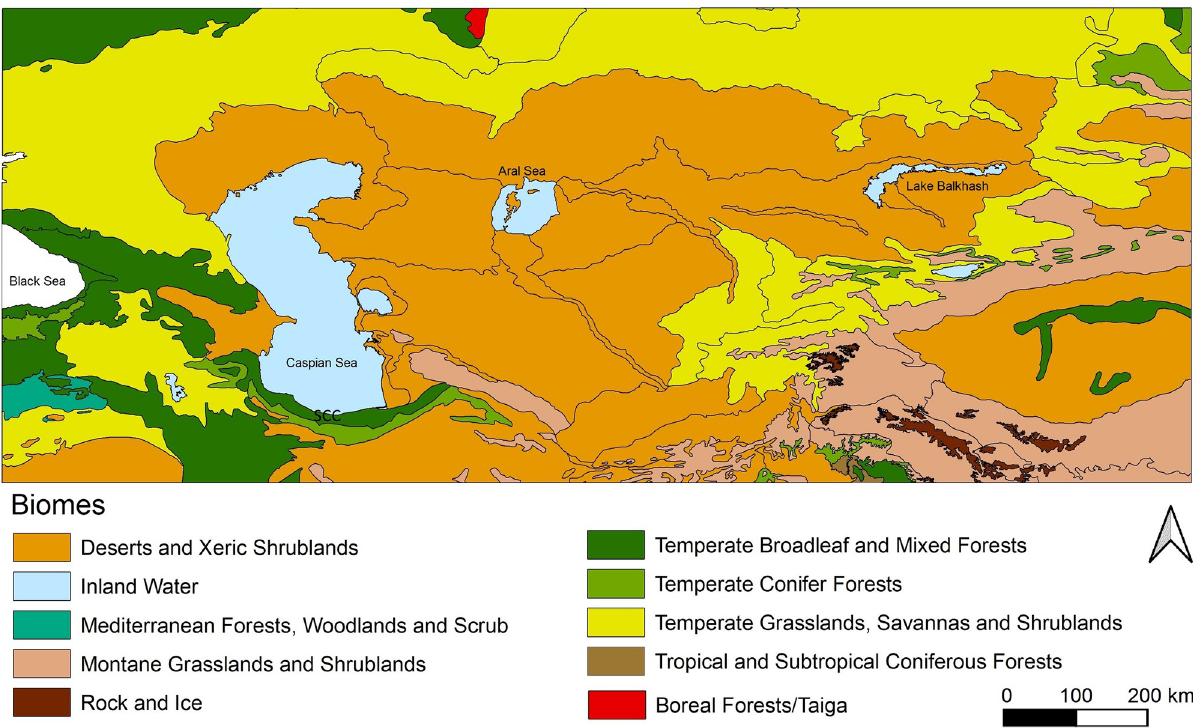
Fig 3. Distribution of terrestrial biomes in the study area. The Southern Caspian Corridor (SCC) is covered by Temperate Broadleaf and Mixed Forests. The biomes data is based on the World Wildlife Fund (WWF) Terrestrial Ecoregions [119].